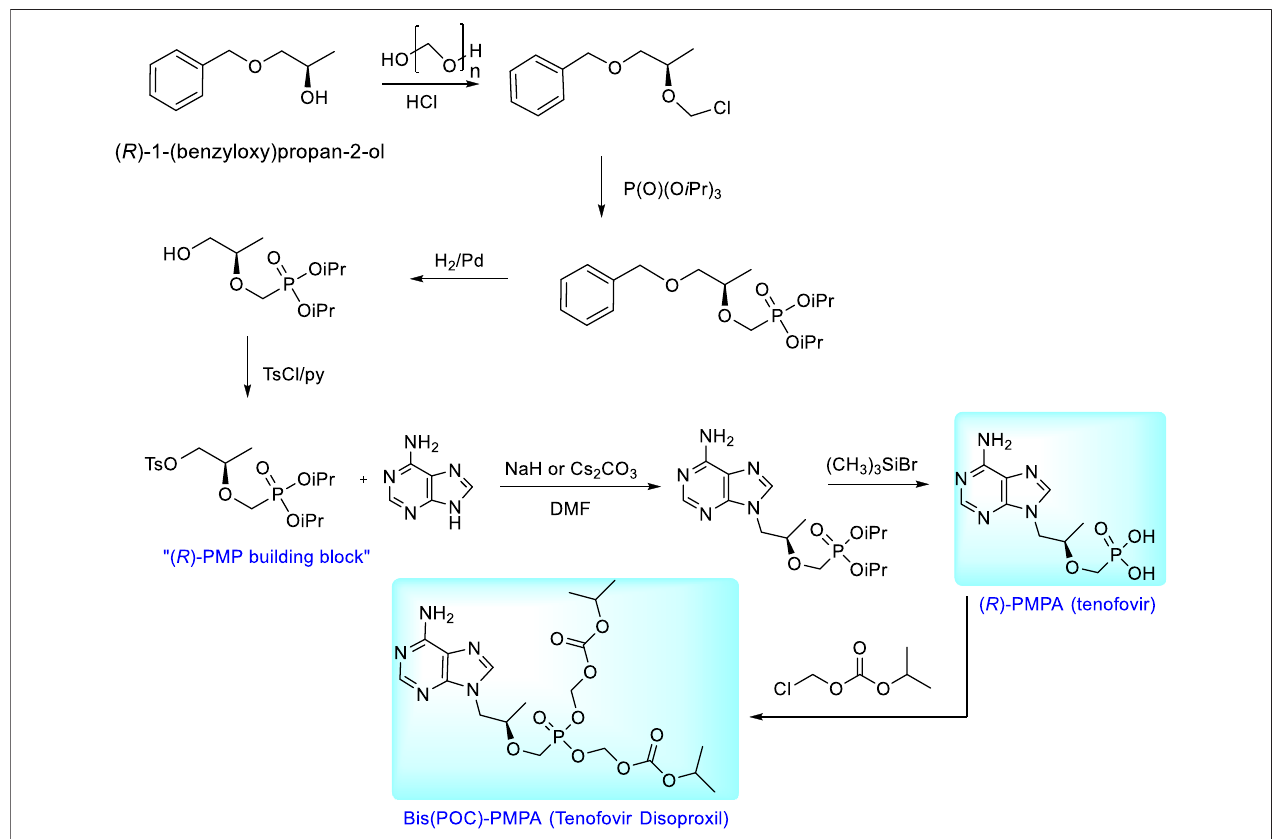
FIGURE 9 | Synthesis of tenofovir and its prodrug, tenofovir disoproxil.